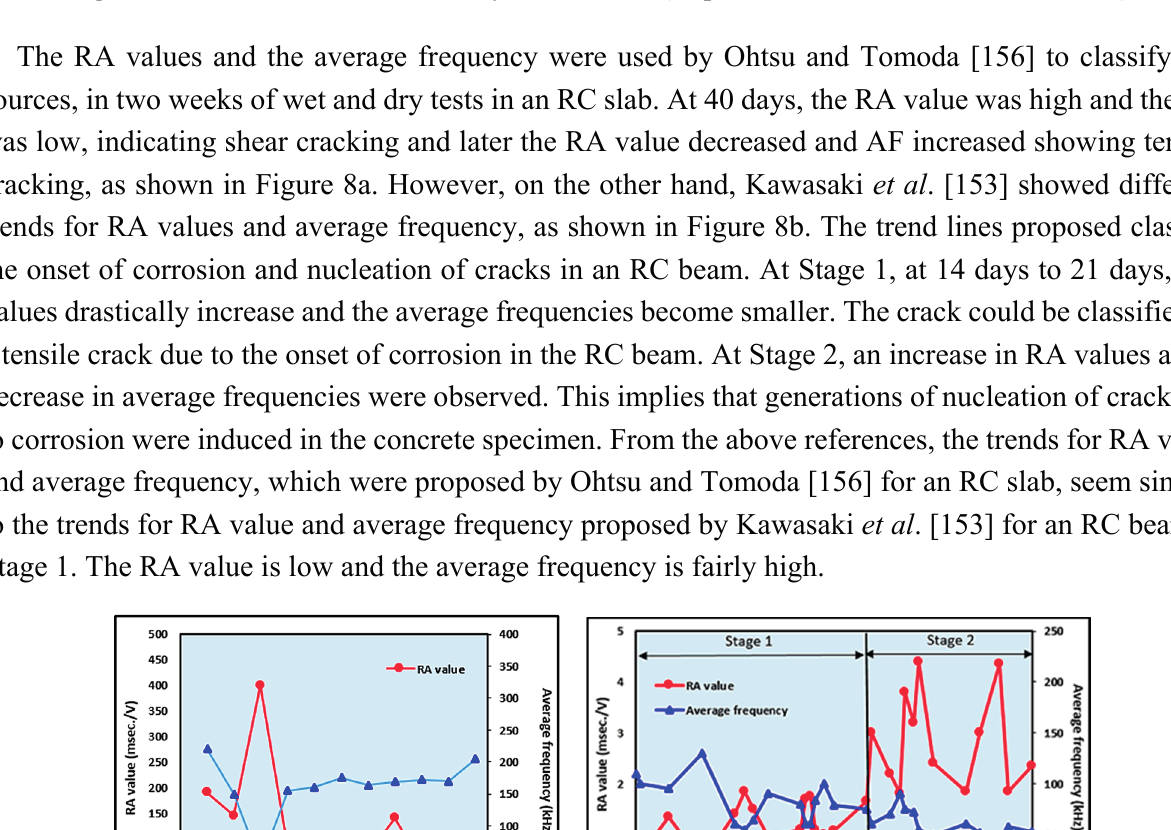
Figure 7. Classification of cracks by AE indexes (Reproduced and modified from [164]).